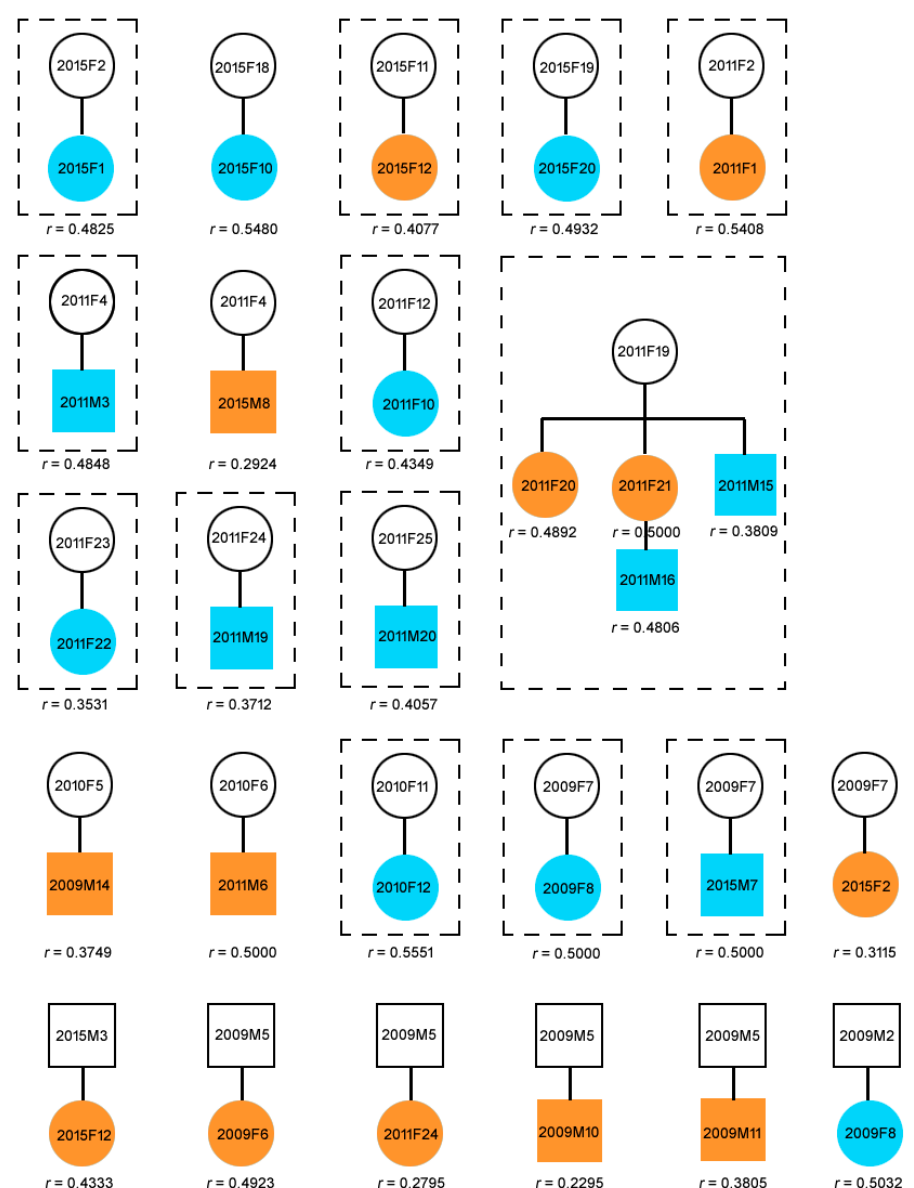
Figure 1. Twenty-one mother-offspring pairs and six father-offspring pairs detected by CERVUS in the Yangtze finless porpoise population living in Poyang Lake. Parent-offspring pairs in dotted boxes were natural groups. The maternal line consisting of three generations was a natural maternal group captured in a sandpit in 2011. Blue represents offspring younger than two years old. Orange stands for offspring older than two years old. Pairwise relatedness index r was calculated by the triadic likelihood estimator (TrioML).